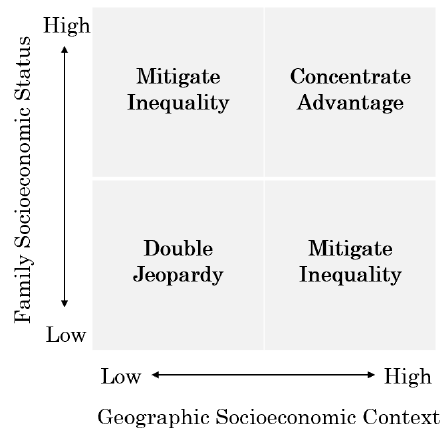
Figure 2. A Conceptual Framework of Intersecting Socioeconomic Gradient and Geographic Context towards ECD.